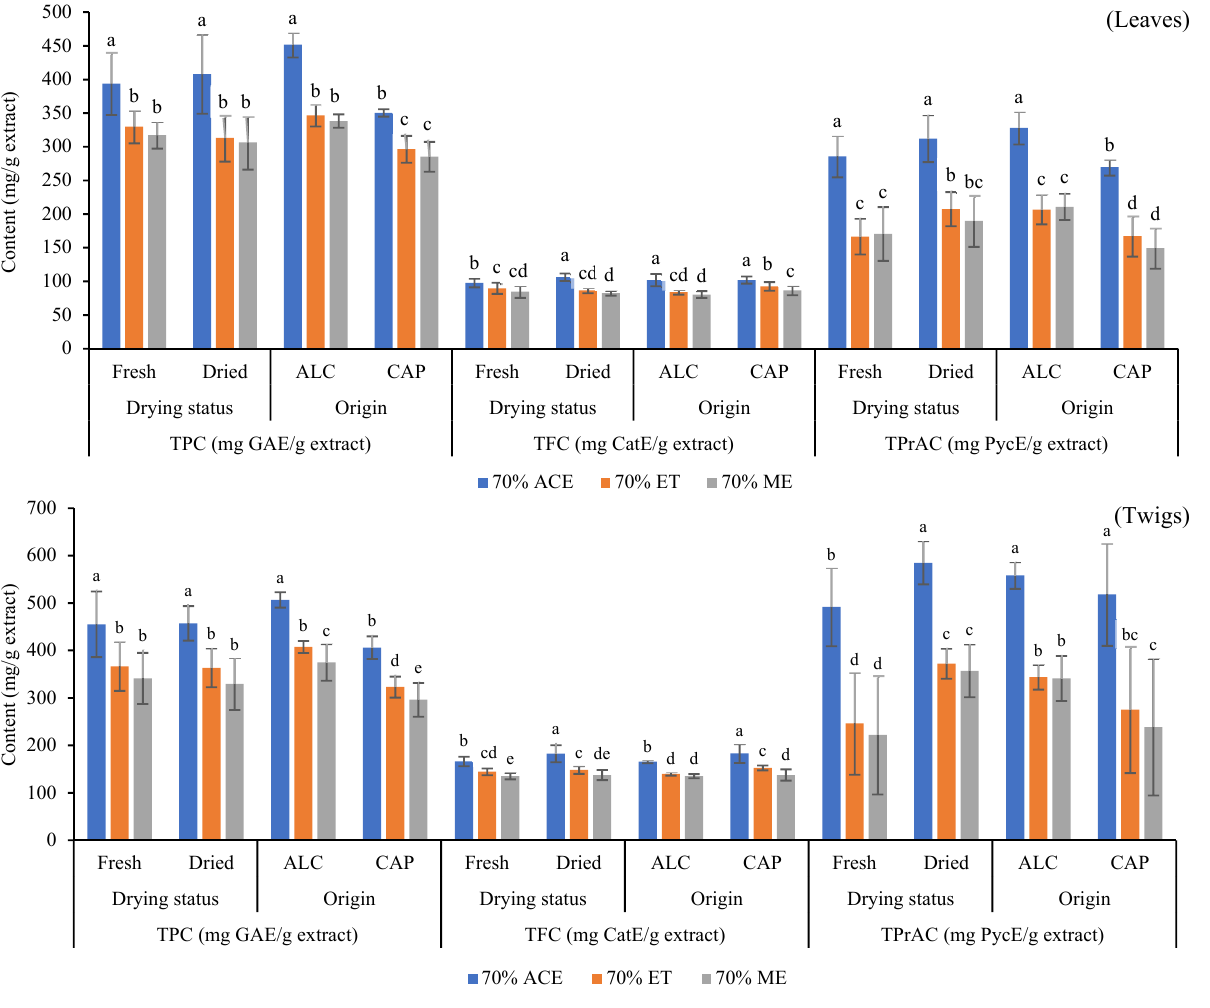
Figure 2. Comparison of the average values of TPC (mg GAE/g extract), TFC (mg CatE/g extract), and TPrAC (mg PycE/g extract) for fresh or dried material (regardless the extraction method and the provenience of the raw material), and for plants from Alcobaça (ALC) and Caparica (CAP) (regardless the extraction method and the drying status); different letters indicate significant differences of means (one-way ANOVA, Tukey test at p < 0.05).